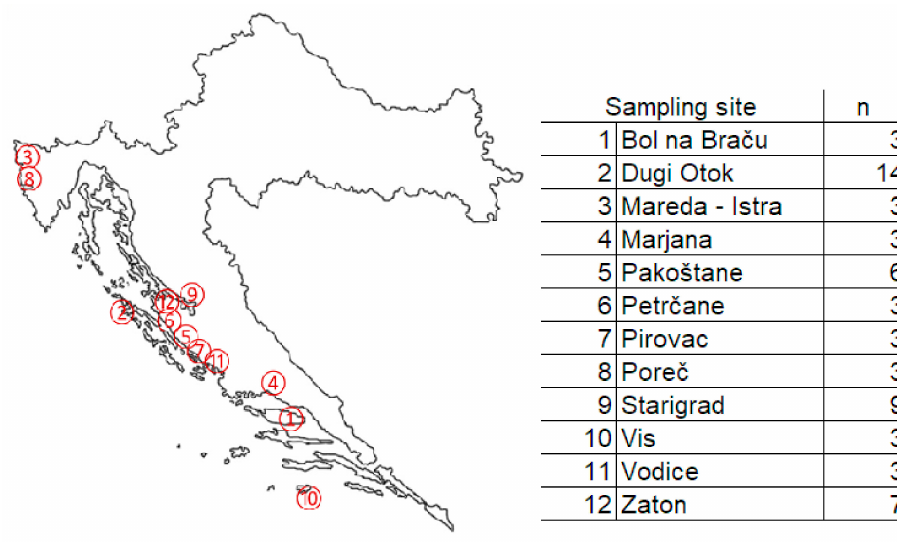
Figure 2. Location of the twelve sampling sites for pine needles in coastal area of